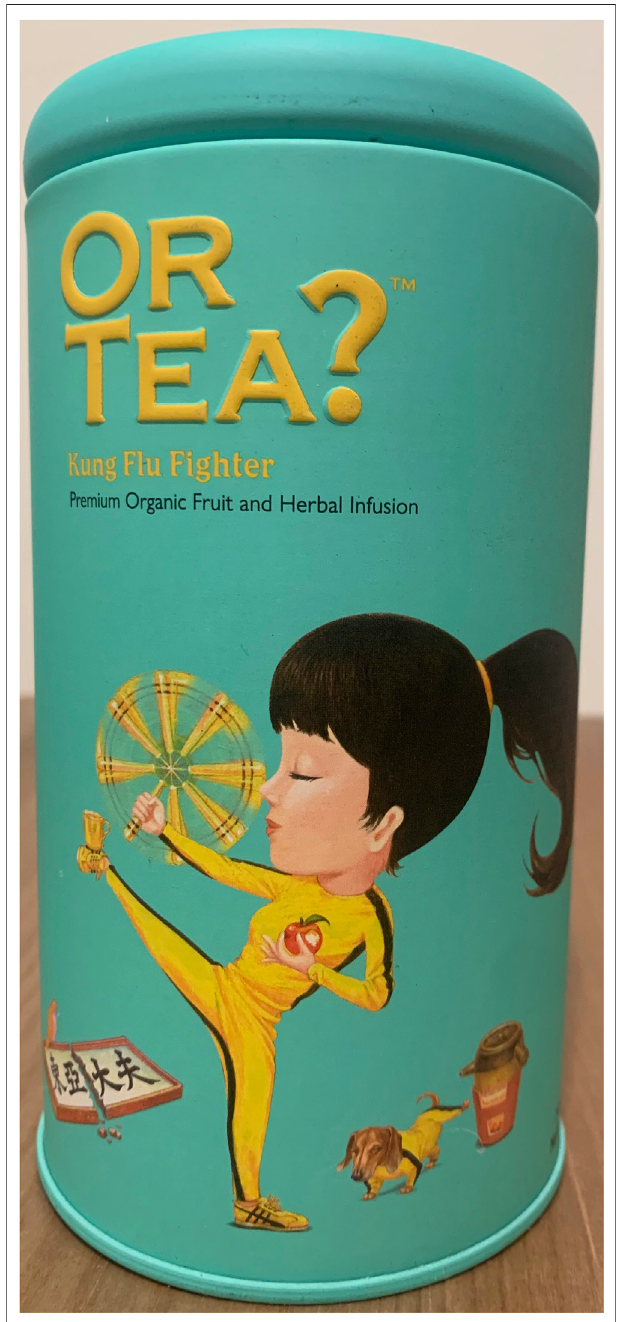
FIGURE 5 | “ Kung fl u ” as Part of a Product Label.